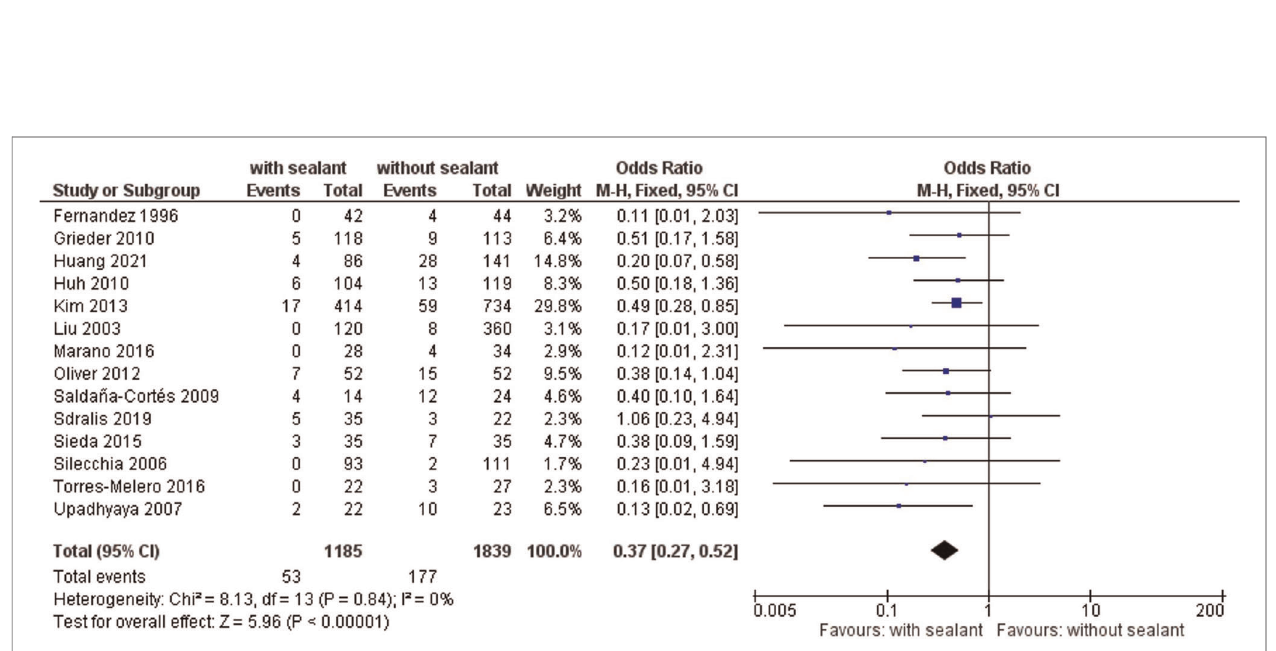
FIGURE 1 | Study fl ow diagram according to the Preferred Reporting Items for Systematic Review and Meta-Analyses (PRISMA) Statement 2020 (42).